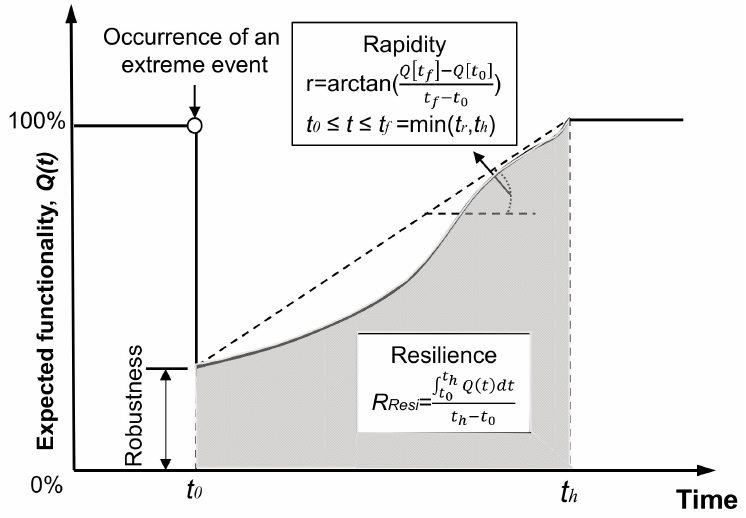
Figure 5. Schematic representation of